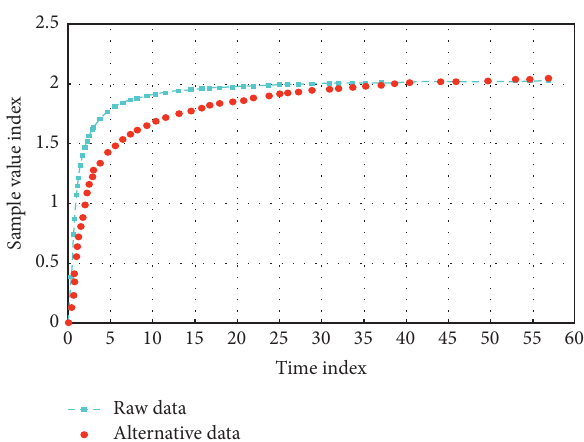
Figure 5: Statistical analysis of original data and alternative data under null hypothesis